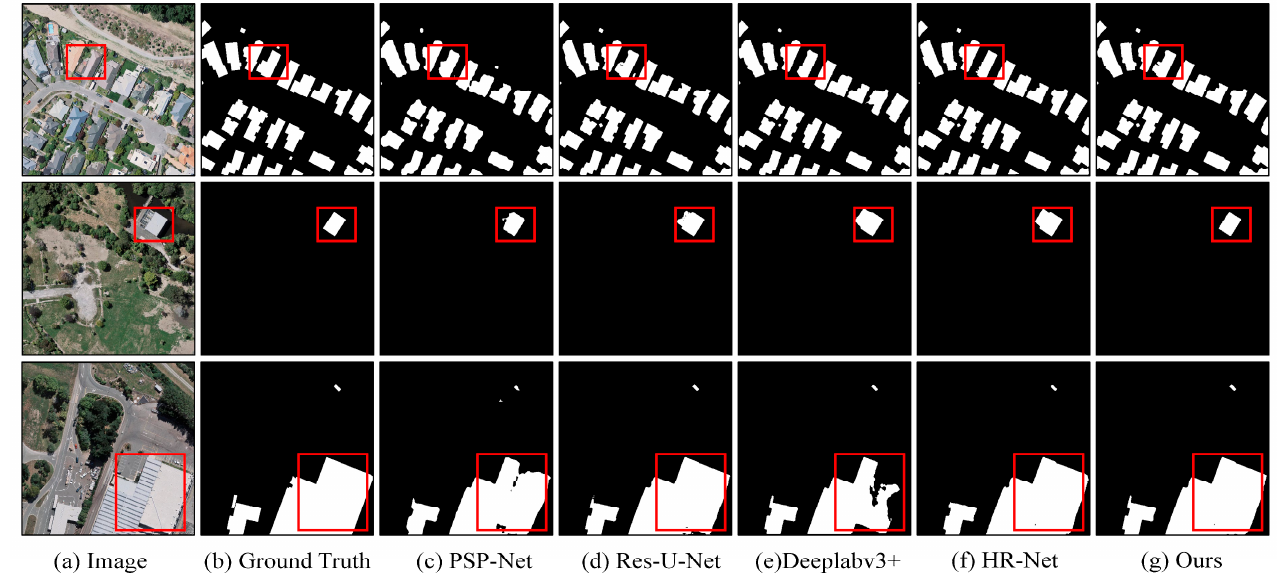
Figure 7. Examples of MEC-Net using the WHU dataset.